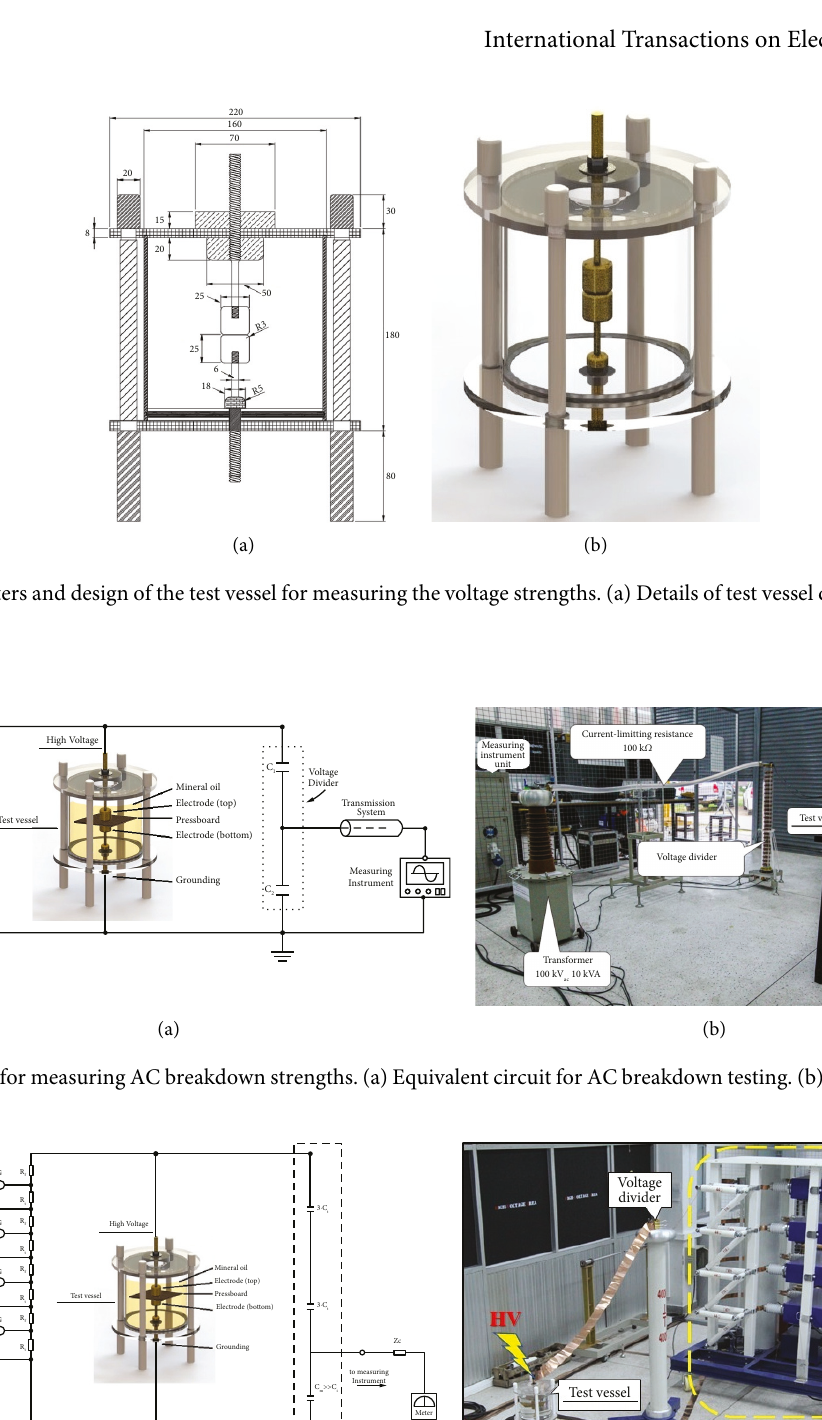
(bottom)Mineral oil Electrode (top)